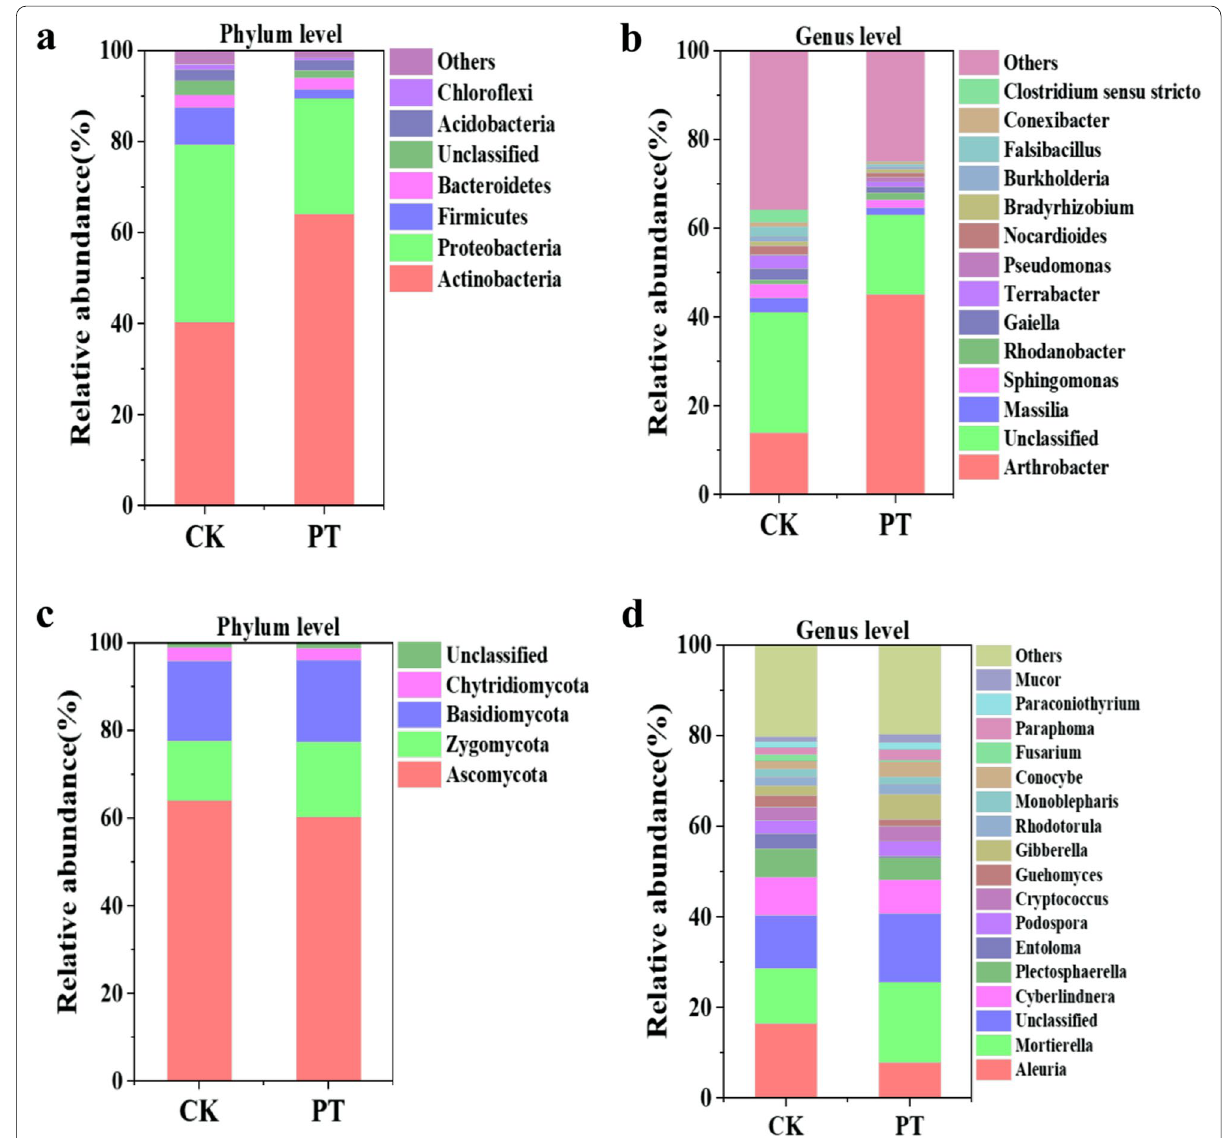
Fig. 4 Comparison of microbial community compositions of tobacco rhizosphere between the CK- and PT-treated rhizosphere soils ( a comparison of bacterial OTUs at the level of phylum with relative abundance 1%, b comparison of bacterial OTUs at the level of genus with relative ≥ abundance 1%, c comparison of fungal OTUs at the level of phylum with relative abundance 1%, d comparison of fungal OTUs at the level of ≥ ≥ genus with relative abundance ≥